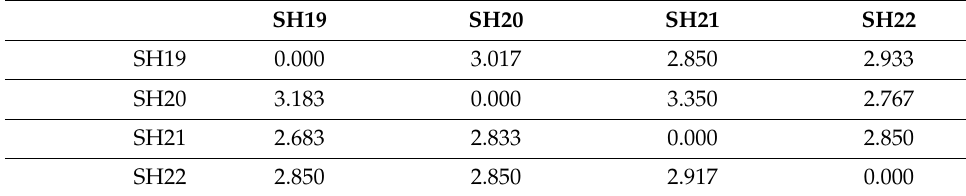
Table 9. Normalized direct relation matrix—human talent sub-criteria.